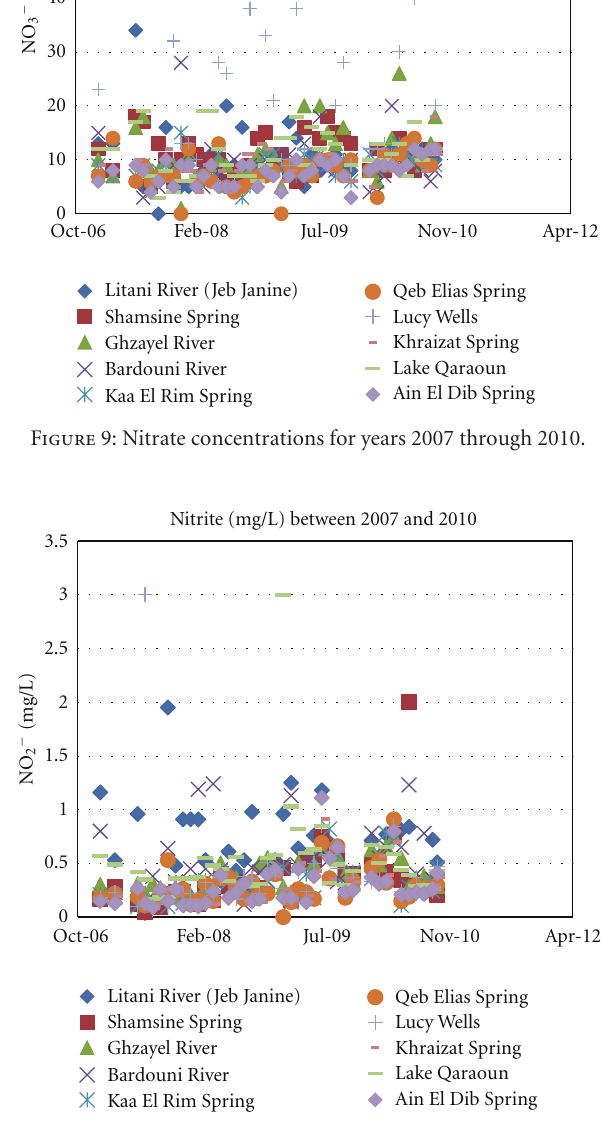
Figure 10: Nitrite concentrations for years 2007 through 2010.